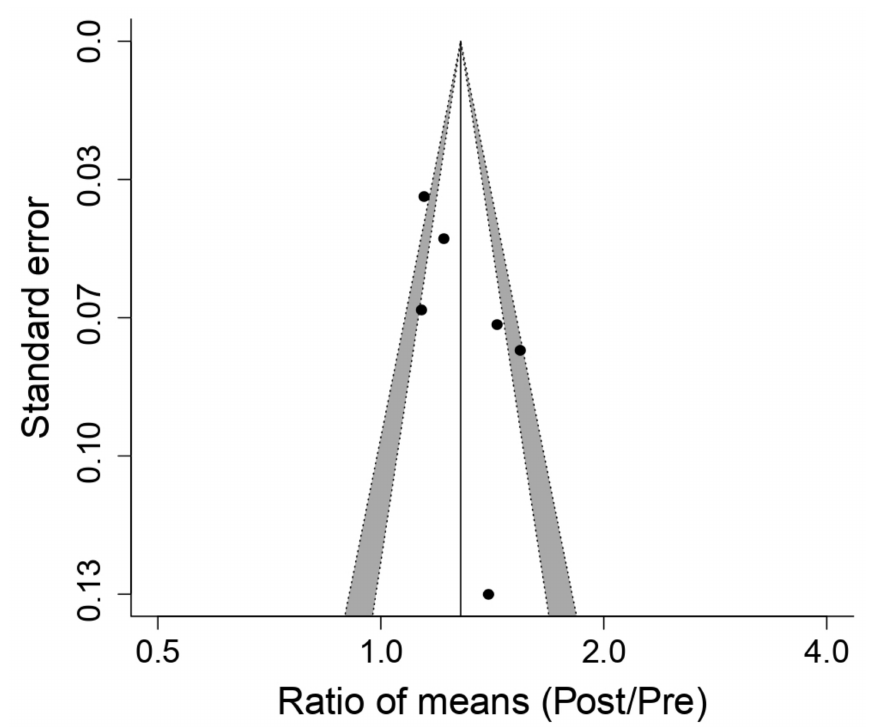
Figure 3. Funnel of the meta-analysis of the effects of inspiratory muscle training with PowerBreath ® on Peak Inspiratory Pressure. Pre: Pre-inspiratory muscle training; Post: Post-inspiratory muscle